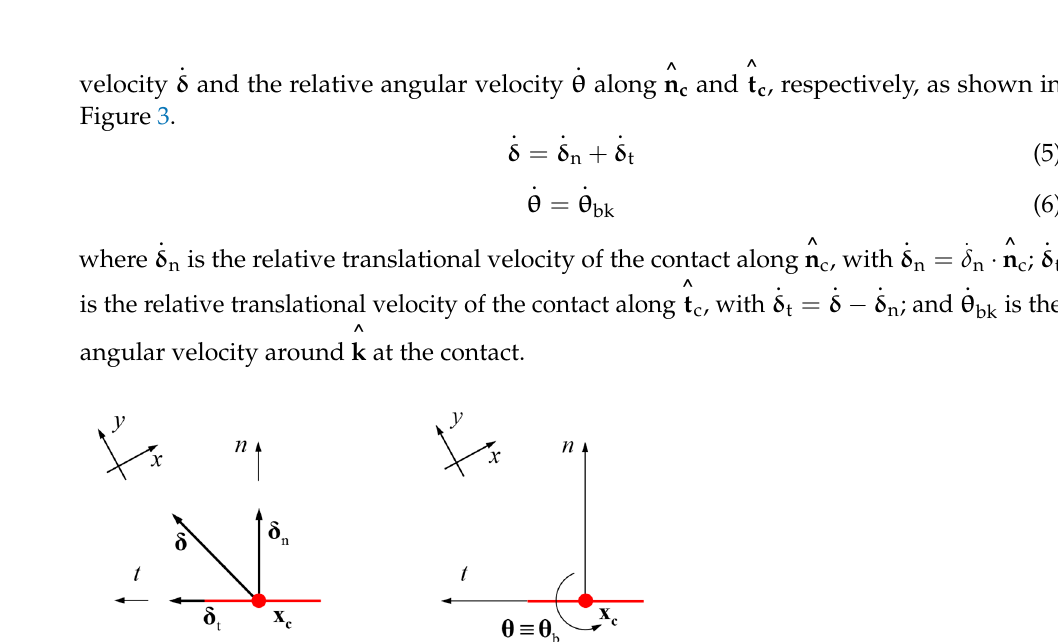
Figure 3. Kinematics of contact with relative rotation and motion of piece surfaces.